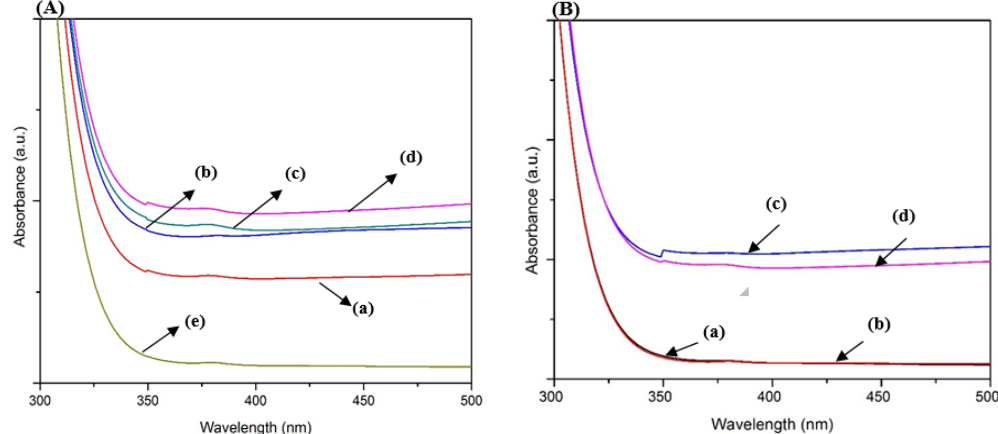
Figure 7. ( A ) UV–Vis absorbance of ZnO microrods on the Zn-Pandan seed layer annealed at temperatures of ( a ) 100, ( b ) 200, ( c ) 300, ( d ) 400, and ( e ) 500 ◦ C. ( B ) UV–Vis absorbance of ( a ) Zn-HMTA seed layer, ( b ) Zn-Pandan seed layer, ( c ) ZnO nanorods on Zn-HMTA seed layer at 500 ◦ C, ( d ) ZnO microrods on Zn-Pandan seed layer at 400 ◦ C.